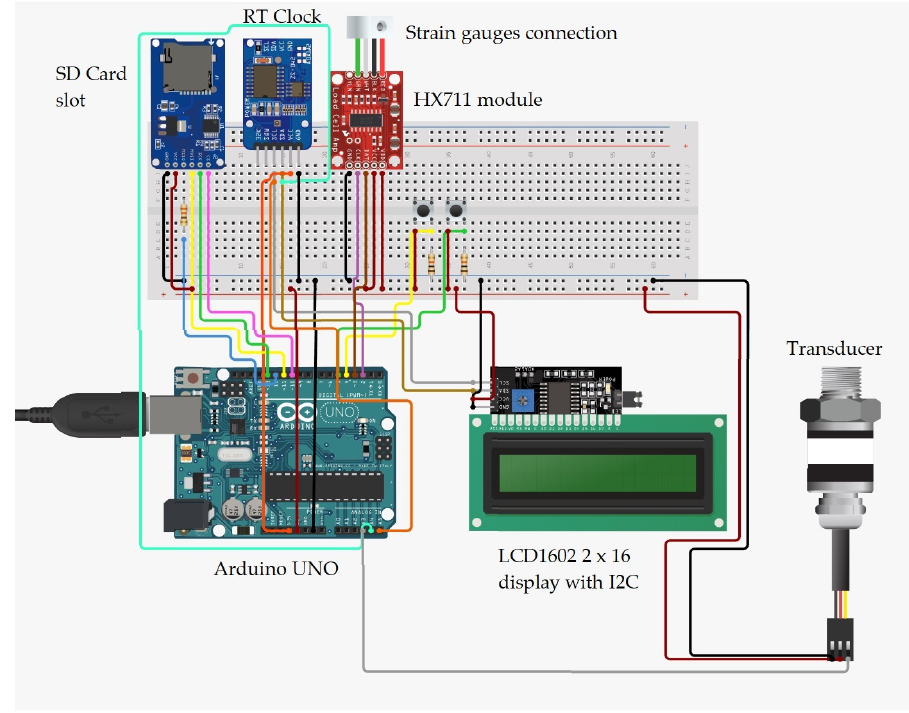
Figure 3. Schematic of the measurement system.